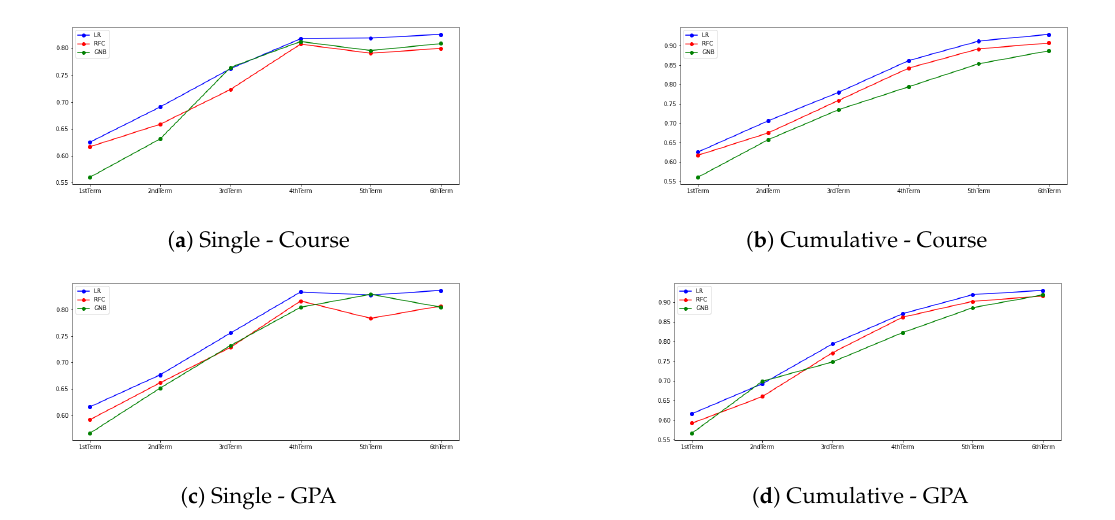
Figure 8. Accuracy plots along the terms of the ML Models with the academic, demographic, and pre-college features.